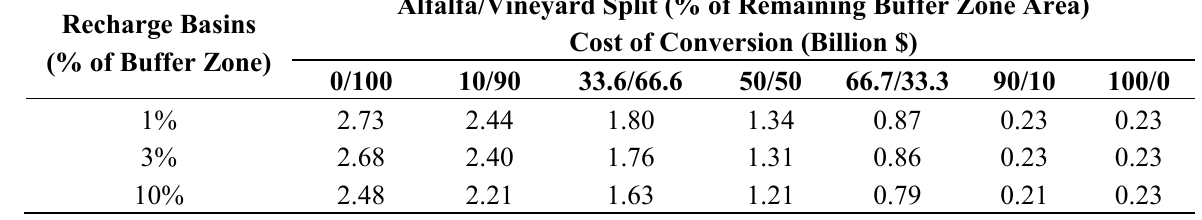
Table 10. Estimated cost of conversion to various proposed recharge buffer zone scenarios. Recharge